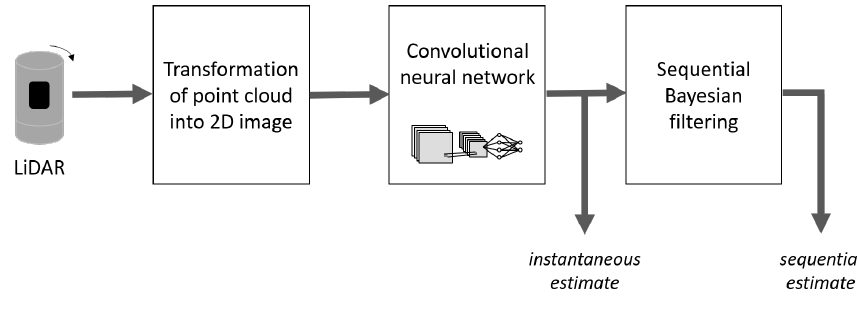
Figure 4. Flow of feature